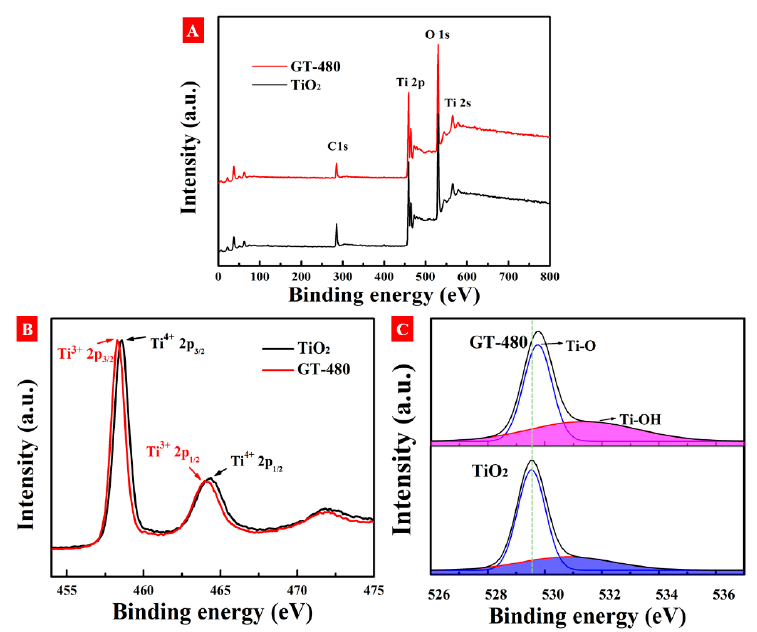
Figure 7. ( A ) XPS survey spectra, ( B ) Ti 2p XPS spectra, and ( C ) O 1s XPS spectra of samples.